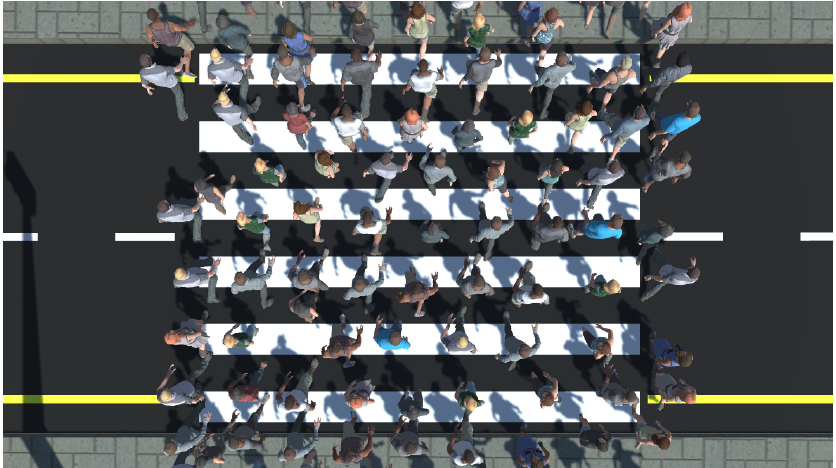
Figure 3. The medium size density model (1.5 pedestrians per square meter) that was used in the conducted experimental